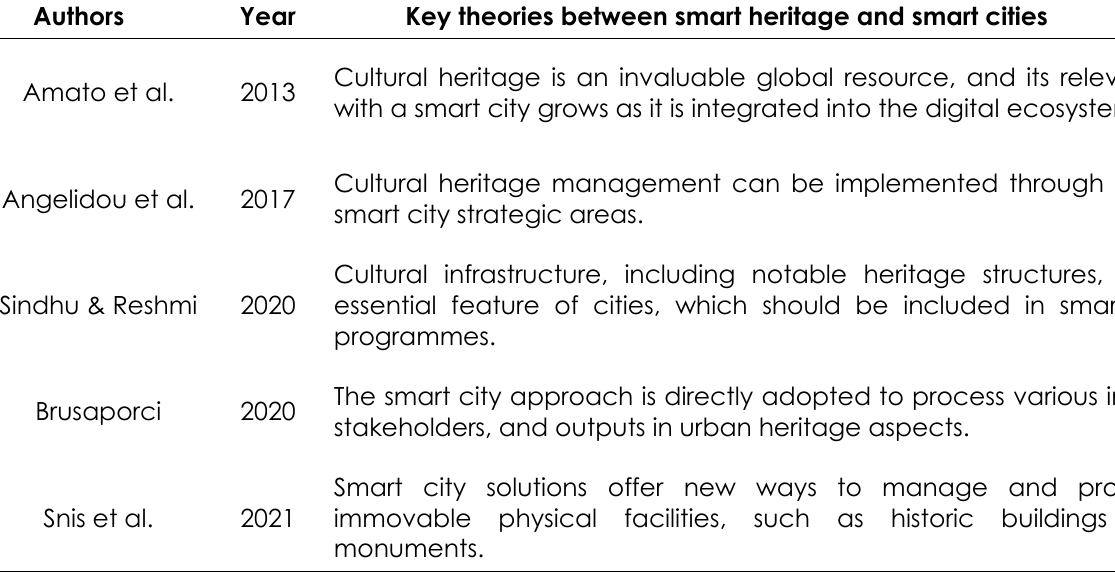
Table 4 . Key Theories Involve Smart Heritage and Smart